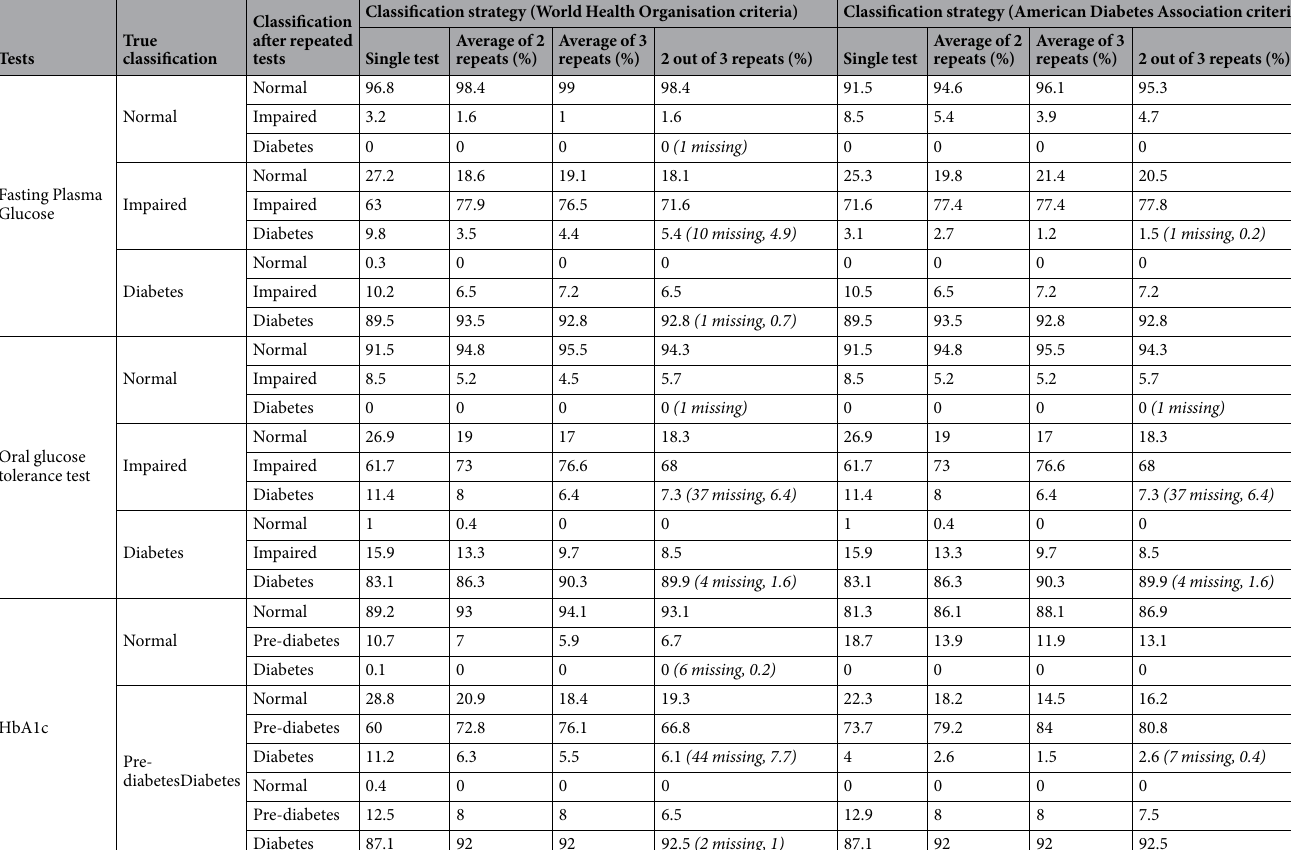
Table 5. Proportion of patients who are misclassified when laboratory testing for diabetes is repeated three times under different classification